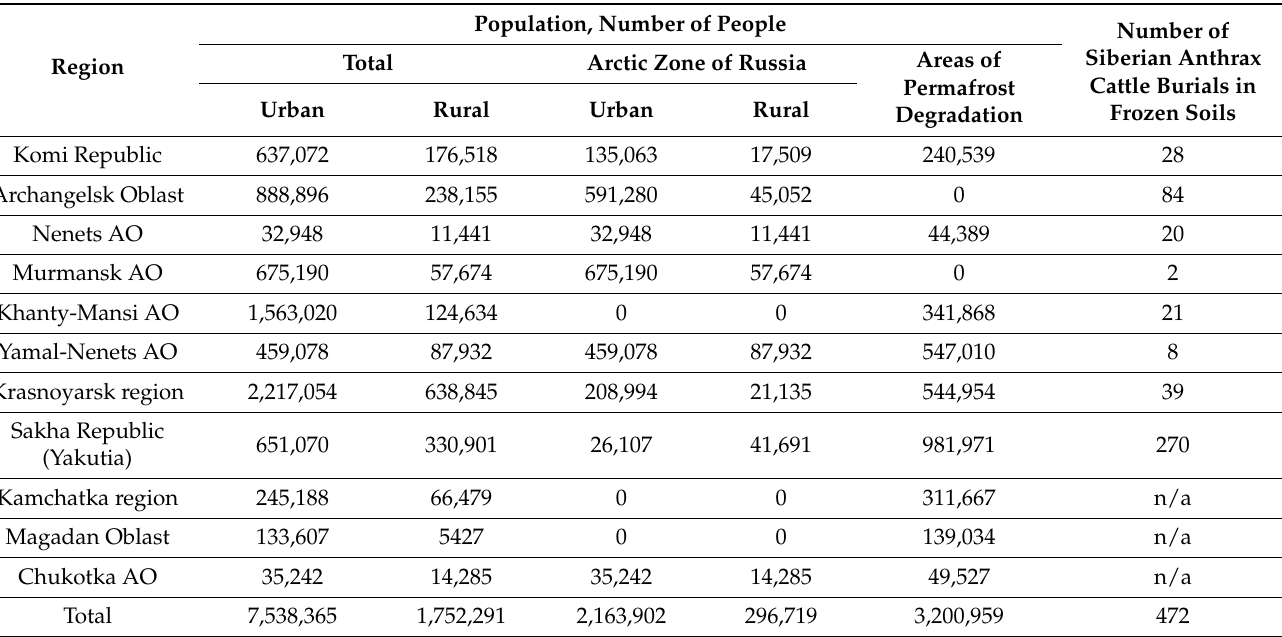
Table 3. Population of the Russian Arctic in 2021, including those who live in the conditions of permafrost